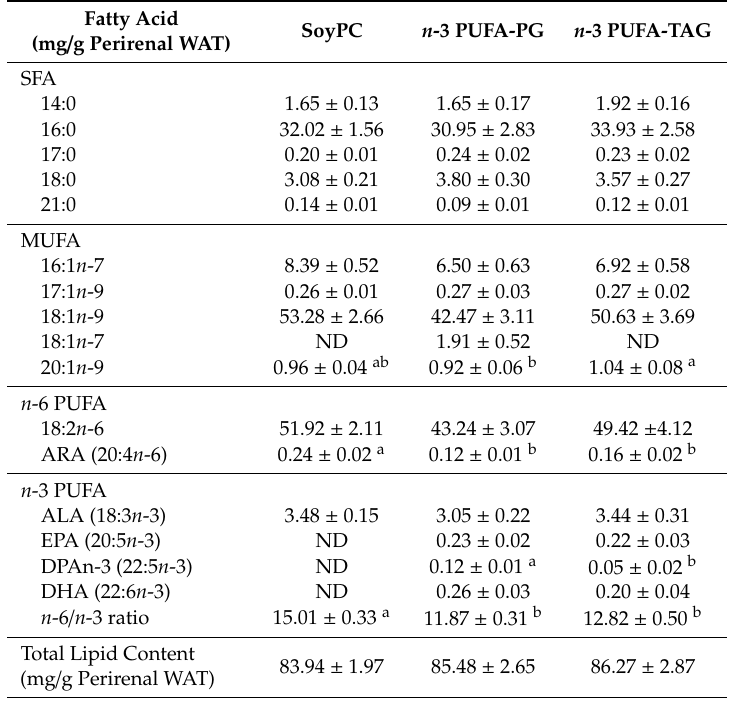
Table 10. Total lipid content and fatty acid composition of the perirenal WAT in KK- A y mice fed experimental diets. Fatty Acid SoyPC n -3 PUFA-PG n -3 (mg / g Perirenal WAT)